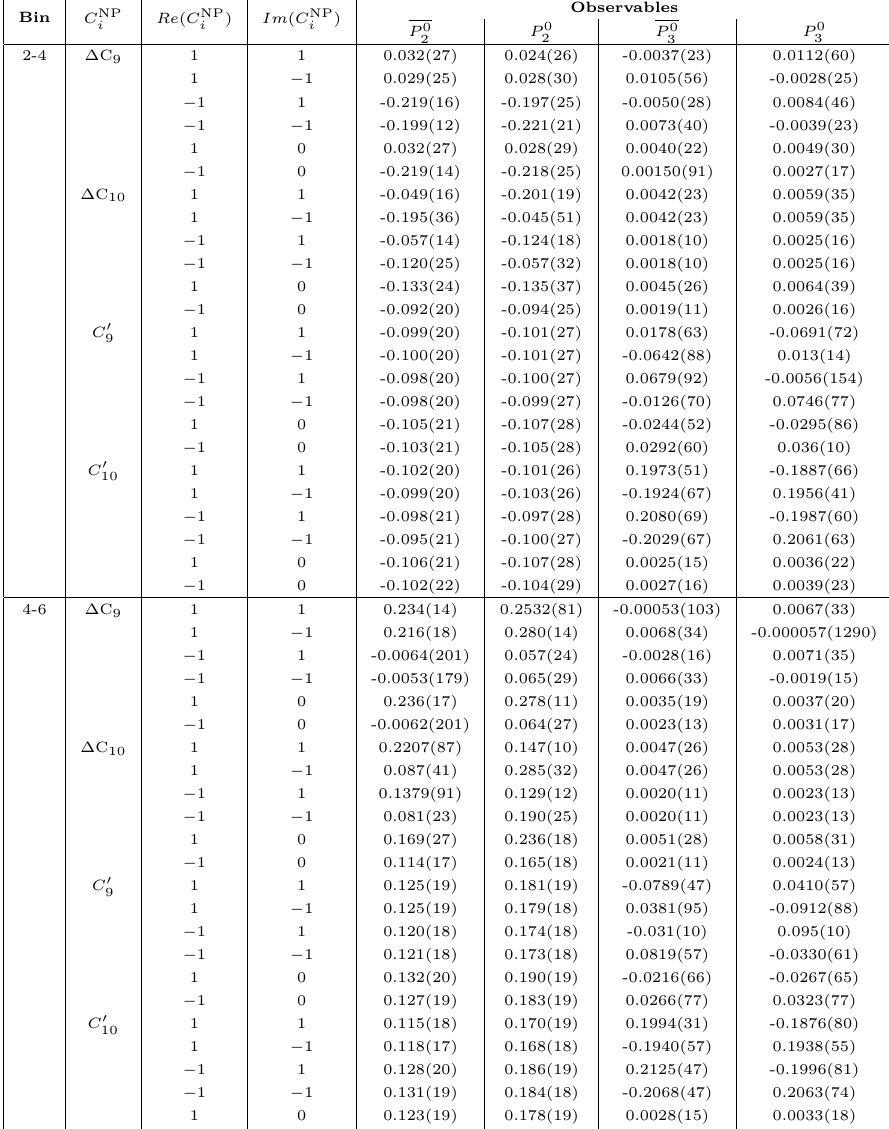
¯ B 0 → ρ 0 ll and C 0 for the q 2 bins 9 , 10 9 , 10